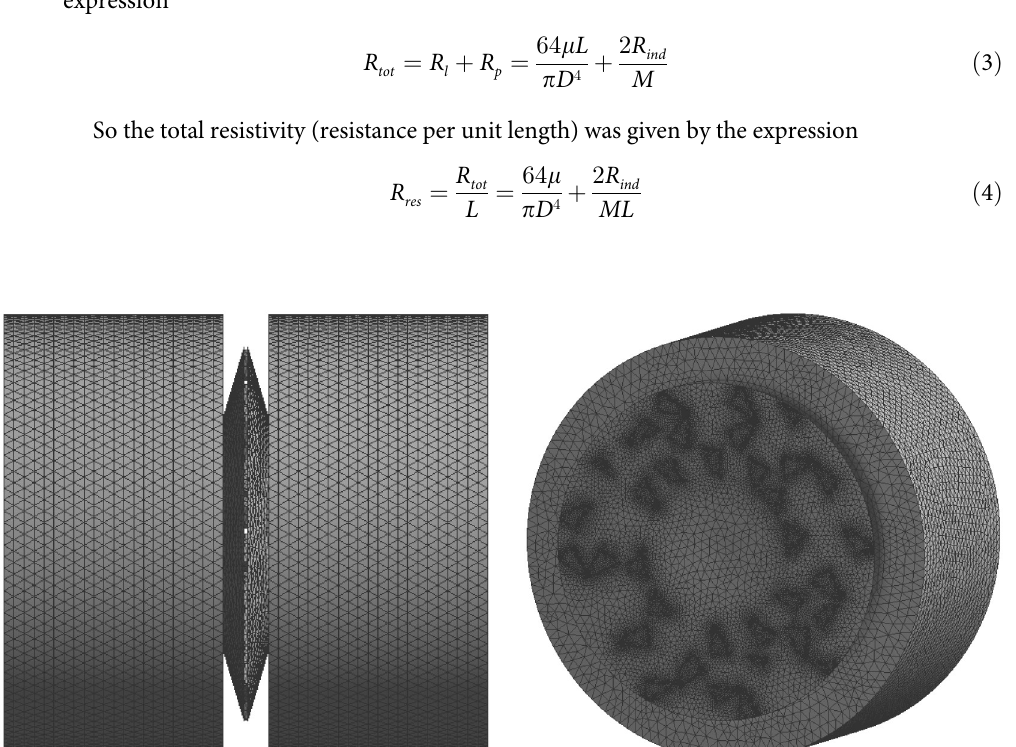
Fig 6. The mesh of the